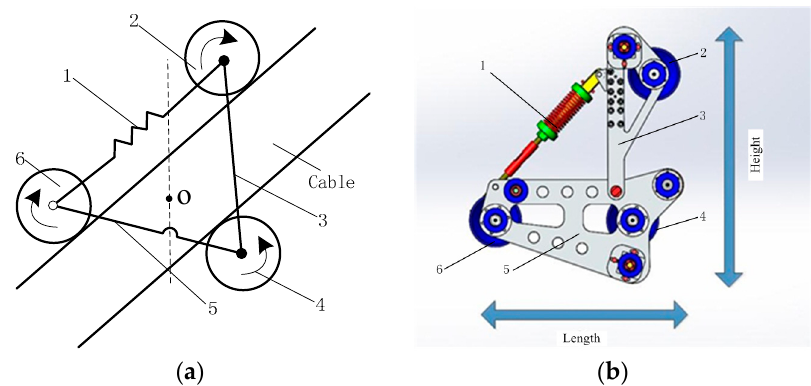
Figure 1. The model of climbing robot. 1—Spring mechanism; 2—Wheel B; 3—Swing plate; 4—Wheel A; 5—Support plate; 6—Wheel C. ( a ) The principle of the climbing robot; ( b ) Left view of the robot.